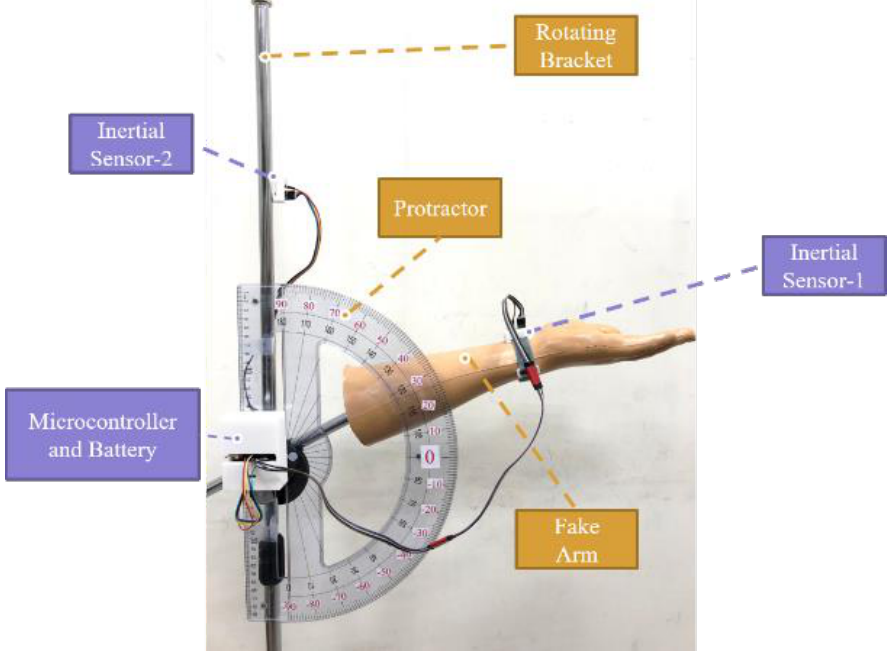
Figure 8. ROMSS verification in the simulated arm.